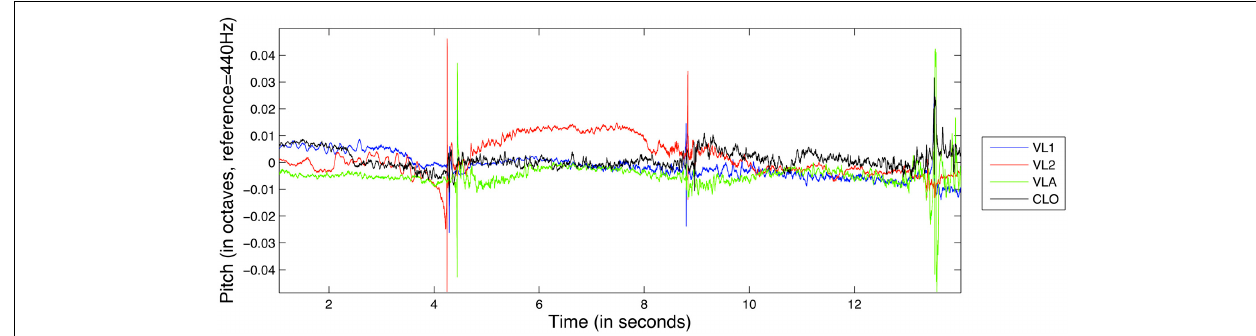
FIGURE 2 | Excerpt from the pitch deviation feature from exercise D1, for all